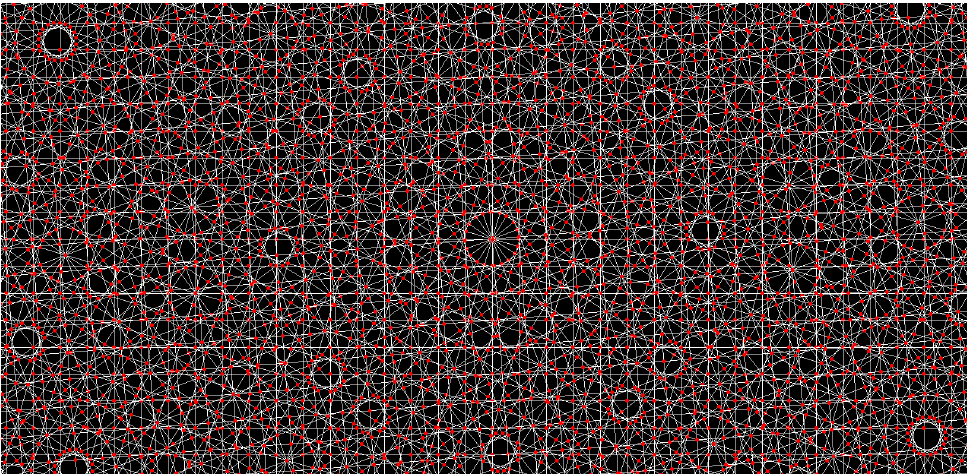
Figure 2. Graph E n that was formed from a sequence of interlacing square lattice graphs by simple local rules, for n =